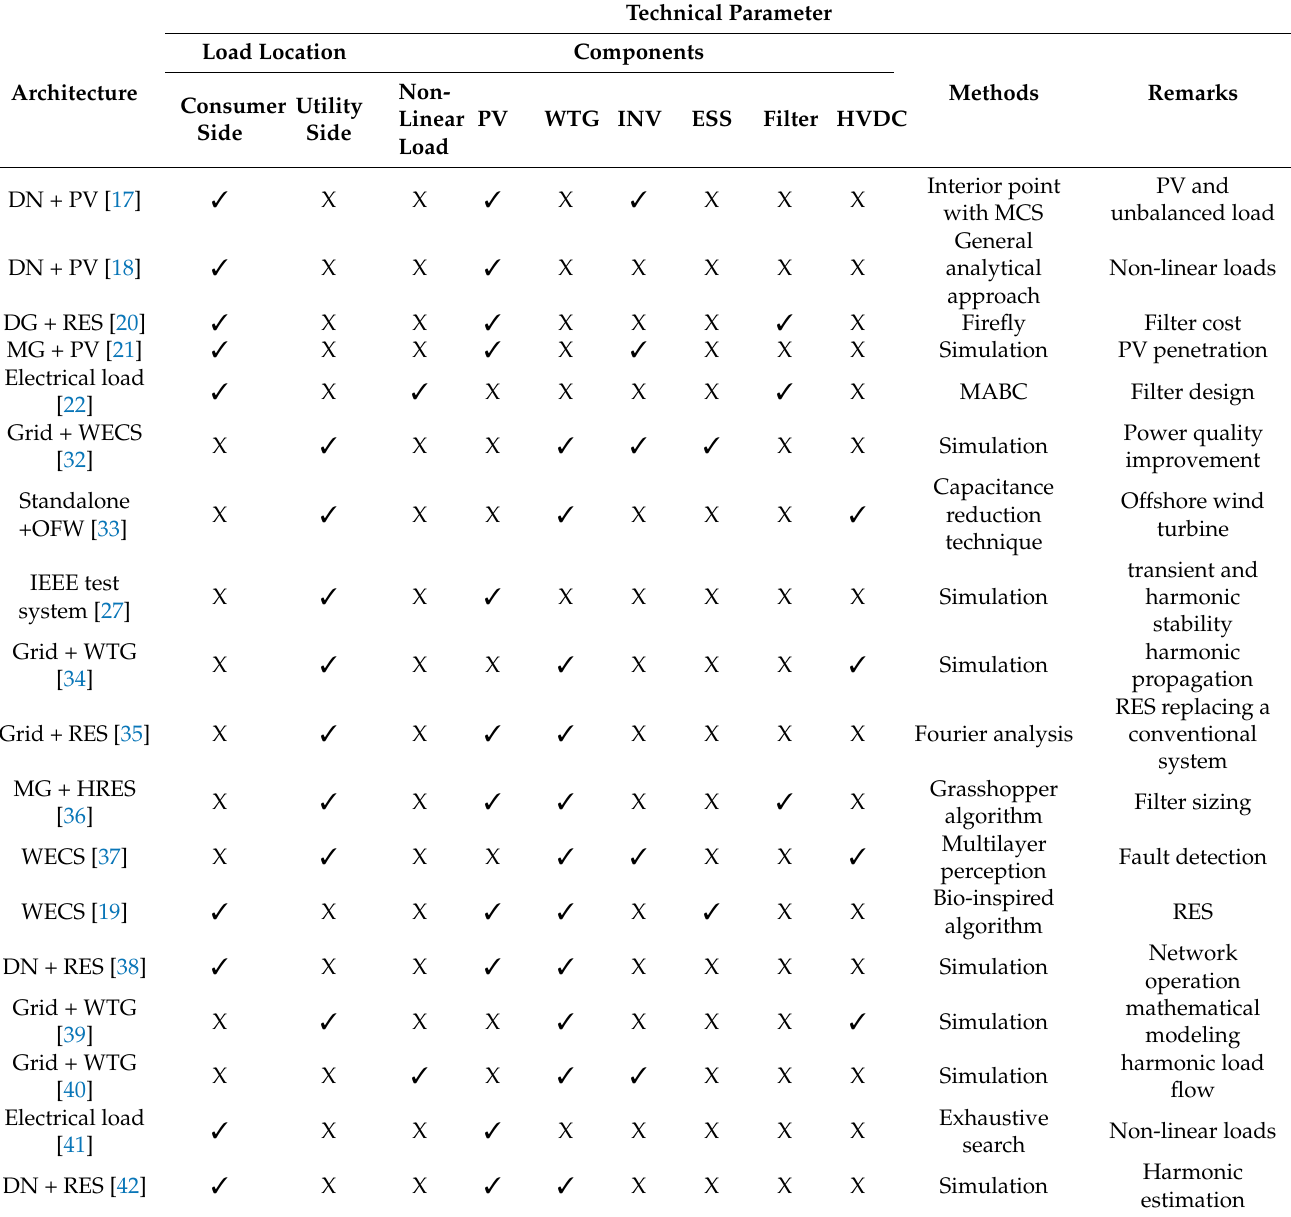
Table 1. An overview of previous research on power